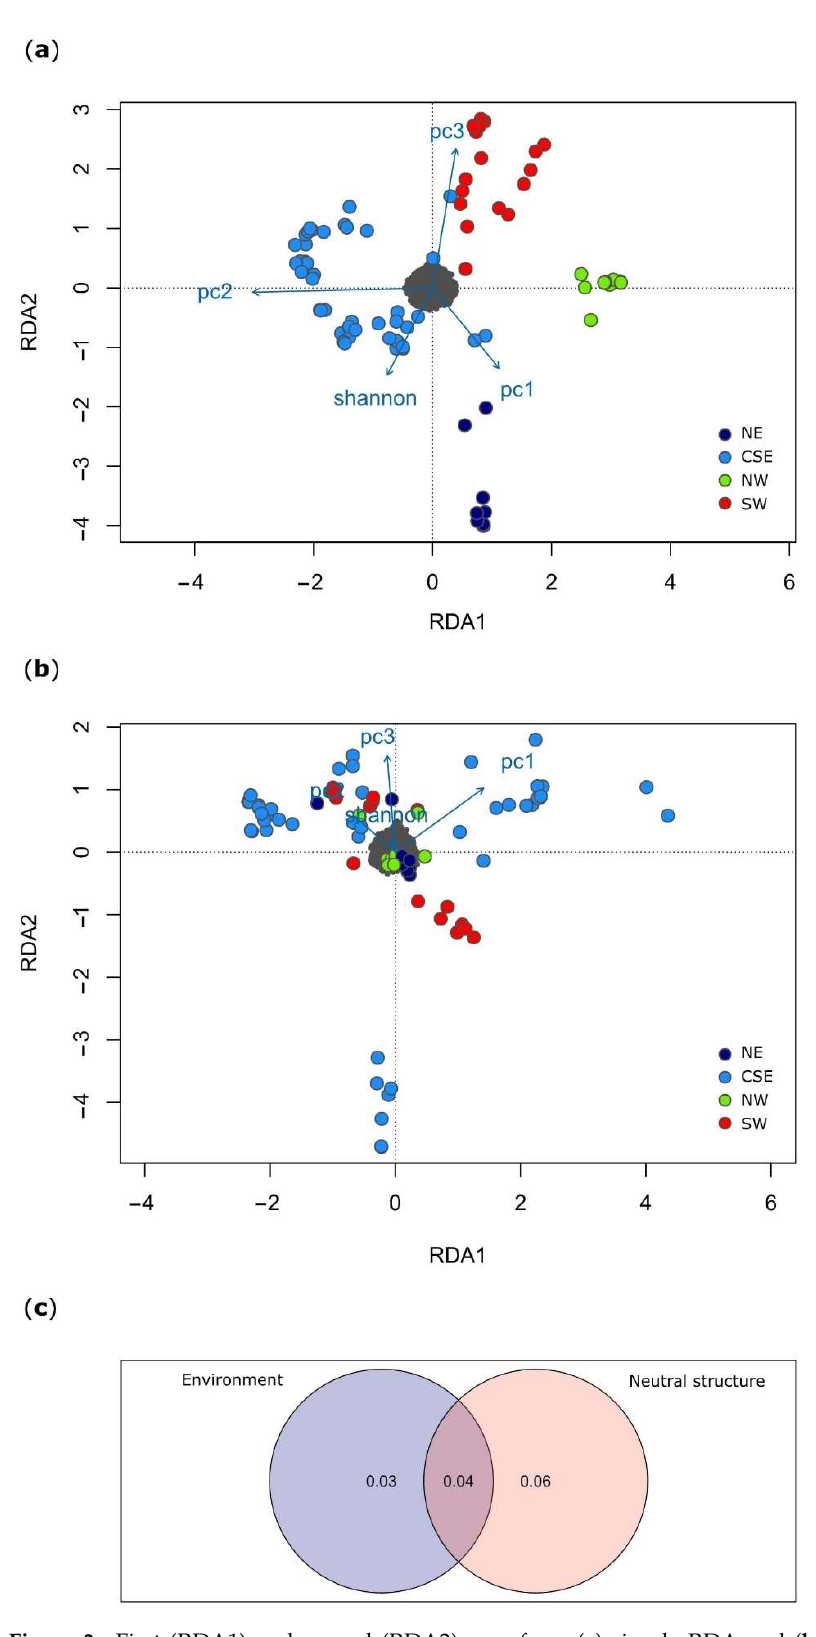
Figure 3. First (RDA1) and second (RDA2) axes from ( a ) simple RDA and ( b ) partial RDA on 81 Sardinian wild boars and 13,290 SNPs; ( c ) variance partitioning between the environmental and the genetic structure components ( c ). NE: northeastern subpopulation; CSE: central and southestern subpopulation; NW: northwestern subpopulation; SW: southwestern